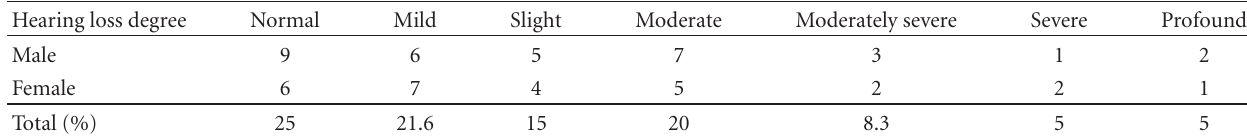
Table 1: Hearing loss degree (male/female) n = 60.